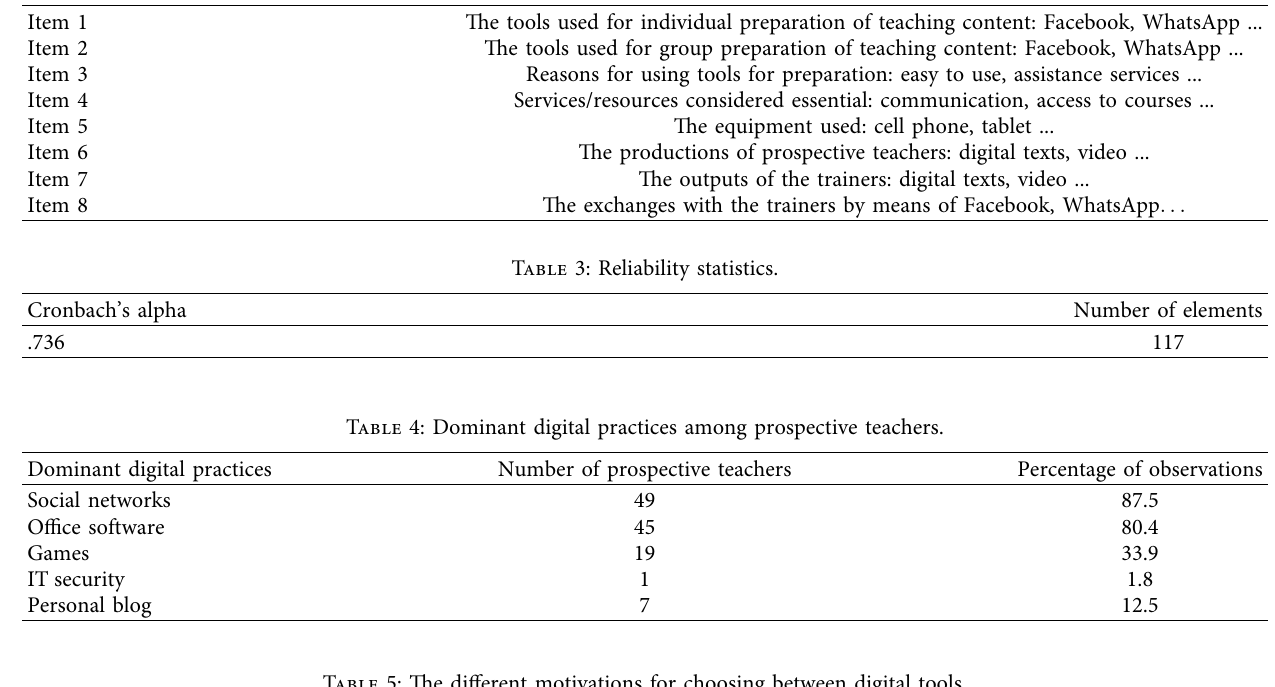
Table 2: Structure of the second part of the questionnaire.